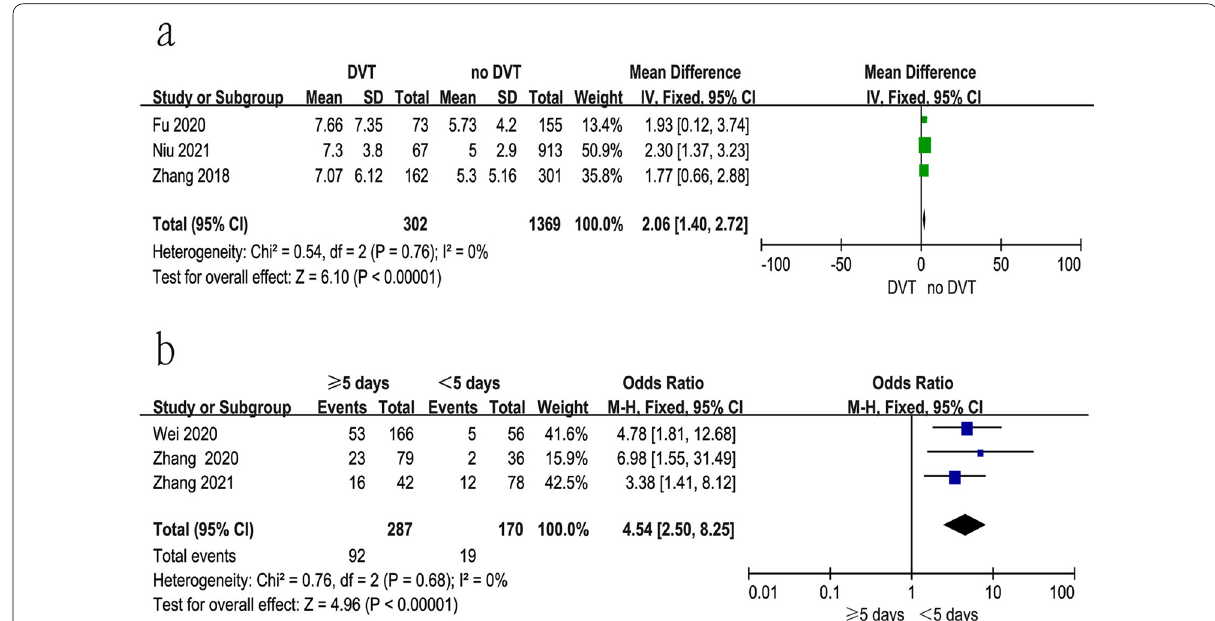
Fig. 6 Forest plot showing prolonged time from injury to admission in 2 groups. CI confidence interval, df degrees of freedom, M-H Mantel– Haenszel. a Prolonged time from injury to admission; b